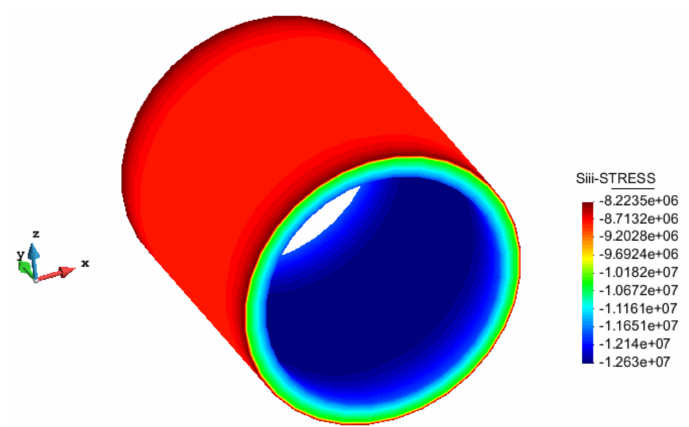
Figure 8. The circumferential stress of the tube core after wire − wrapping and outdoor storage (pipe